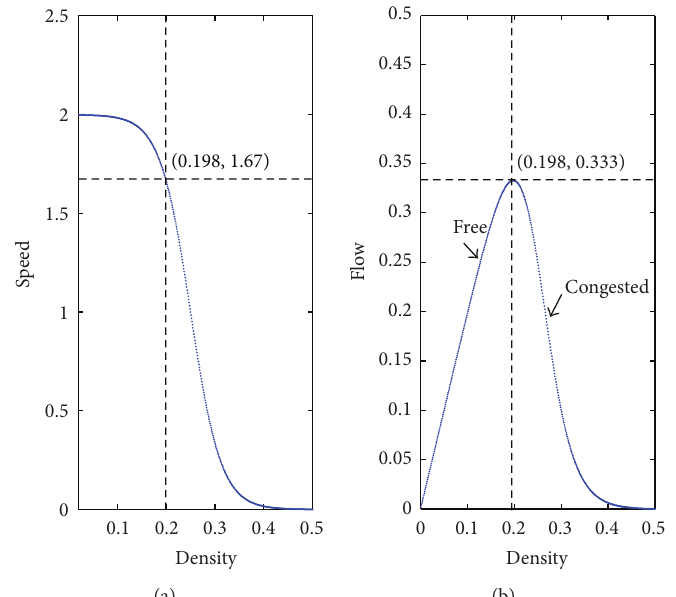
Figure 2: Schematic illustration of speed and flow as a function of the density for 𝜌 𝑐 = 𝜌 0 = 0.25 , V max = 2 m/s. (a) The speed-density curve. (b) The flow-density curve.